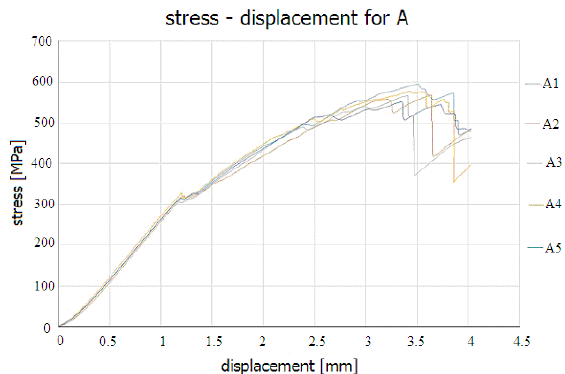
Figure 5. Mechanical characteristics of the 3-point bending test for reference samples–group A.